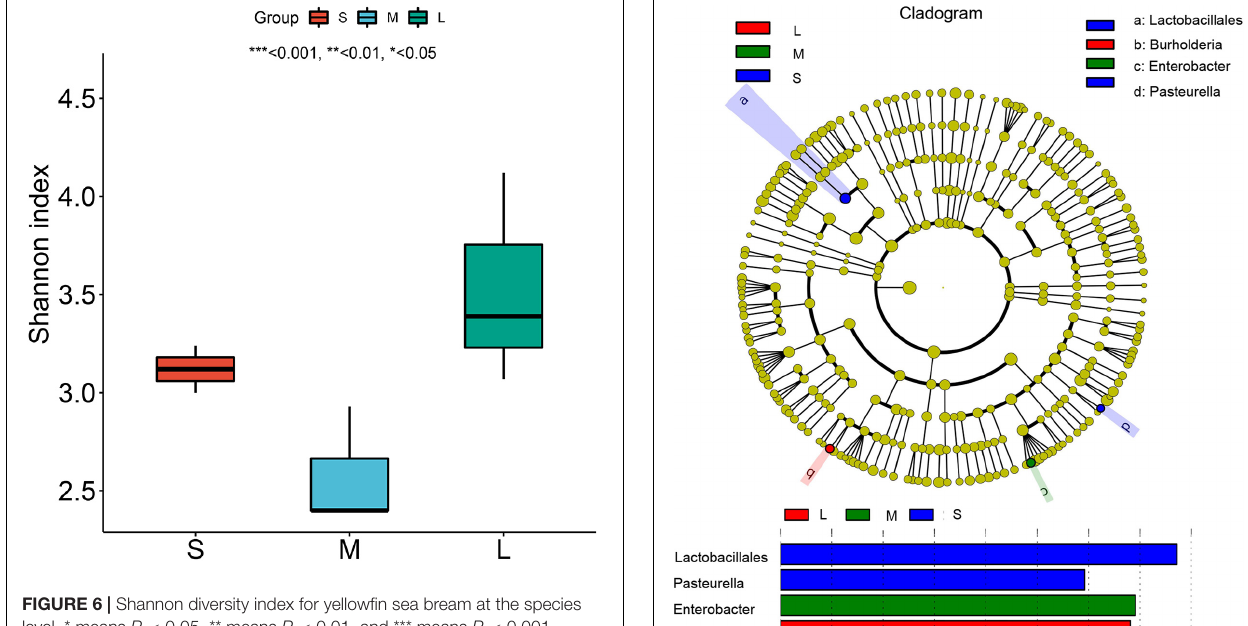
rich in biological resources and diverse habitats (Qin et al., 2019).